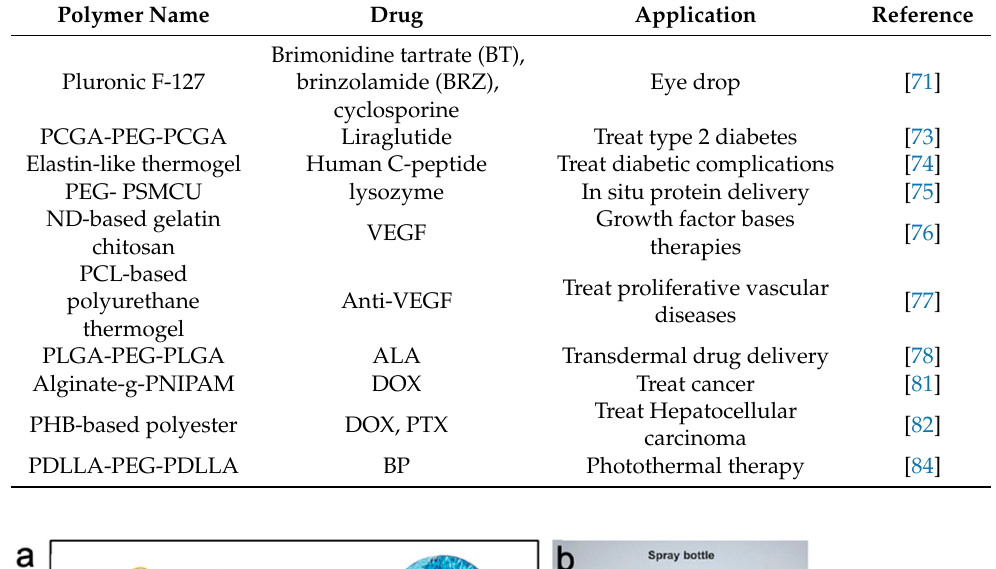
Table 2. Thermogel systems for drug delivery.